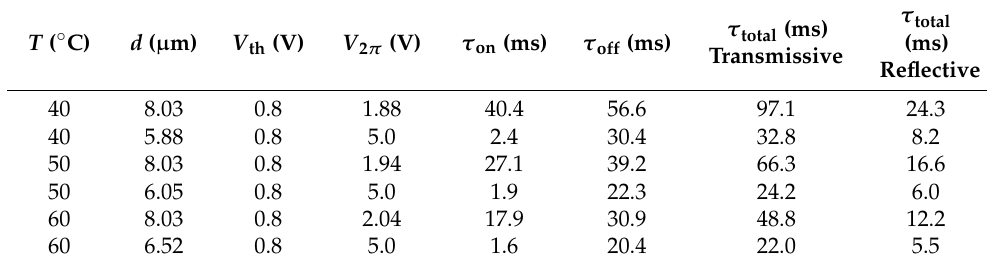
Table 3. Measured response time of a transmissive LCM-1107 cell with d = 8.03 µ m and the extrapo- lated response time to the corresponding reflective cells at 40, 50 and 60 ◦ C with λ = 1550 nm.